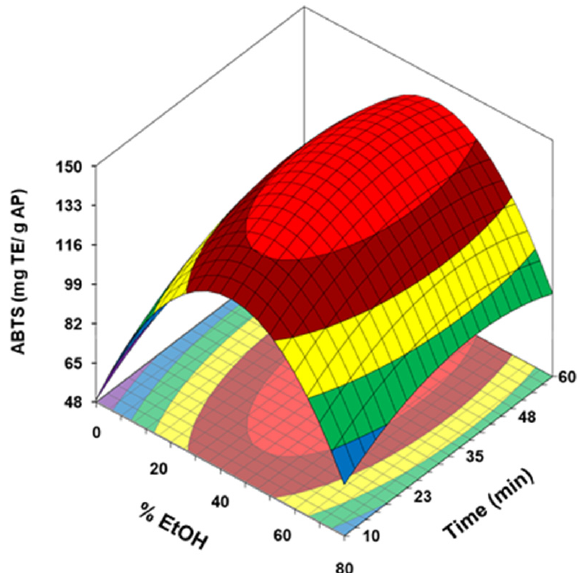
Figure 2. Response surface of total flavonoid content (TFC) for AP as a function of ethanol concentra- tion and ultrasonication time.